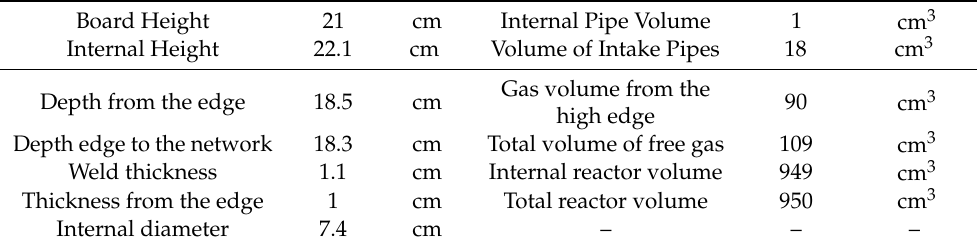
Table 1. Geometric and volume specification about the lab-scale